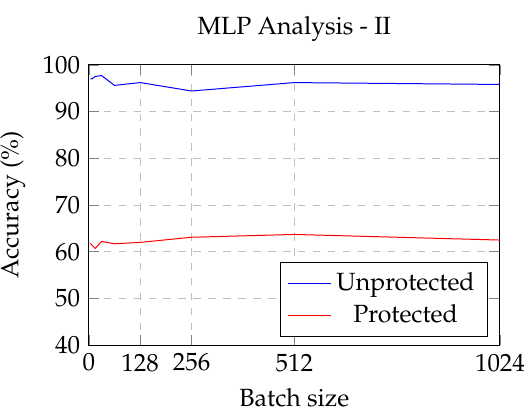
Figure 13. Impact on accuracy of Batch size on MLP model.